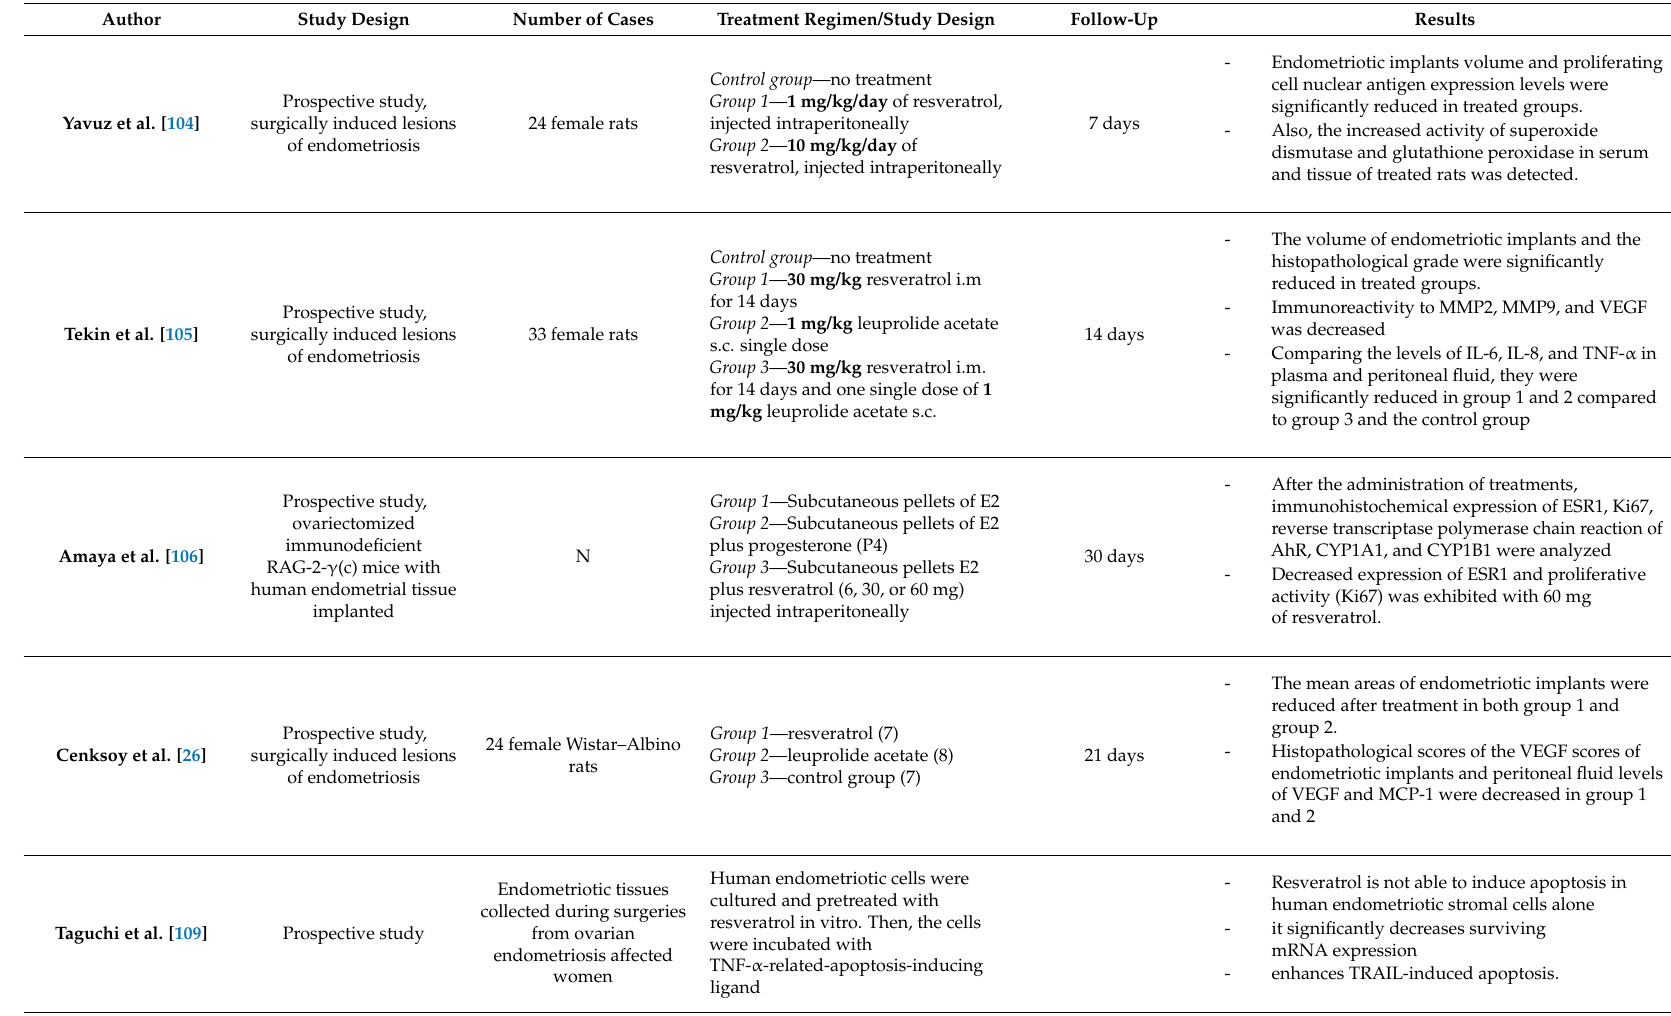
Table 1. Preclinical studies regarding the effects of resveratrol in